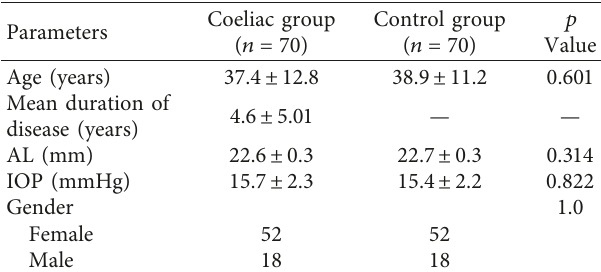
Figure 1: A representative enhanced depth imaging (EDI) mode of spectral domain optical coherence tomography (SD-OCT) image showing the choroidal thickness measurements of a coeliac patient. Table 1: Demographic and ocular characteristics of coeliac and control